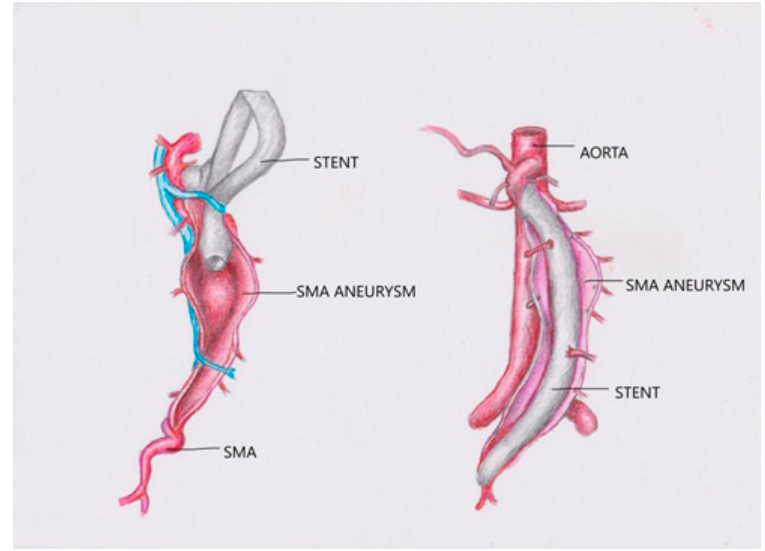
Figure 10. Endovascular repair